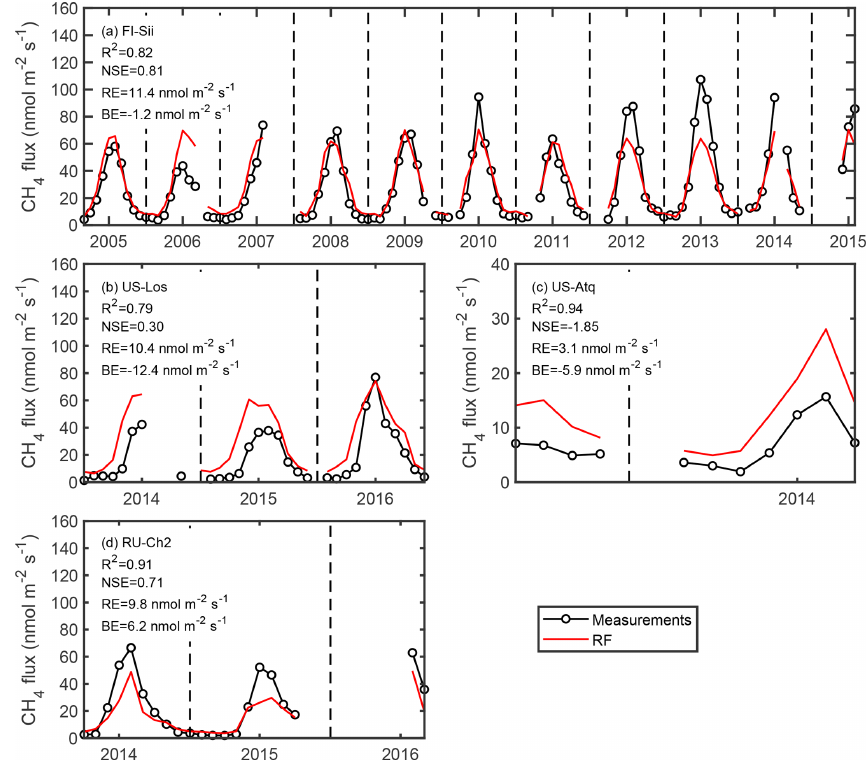
Figure 5. Time series of modelled CH 4 emissions (red lines) together with validation data (circles) at four example sites: (a) Siikaneva oligotrophic fen in Finland, (b) Lost Creek shrub fen in Wisconsin, USA, (c) Atqasuk wet tundra in Alaska, USA, and (d) Chersky wet tundra in northeastern Siberia, Russia. Dashed vertical lines denote a new year. Note the changes in y axis scales. Site-specific model performance metrics are also